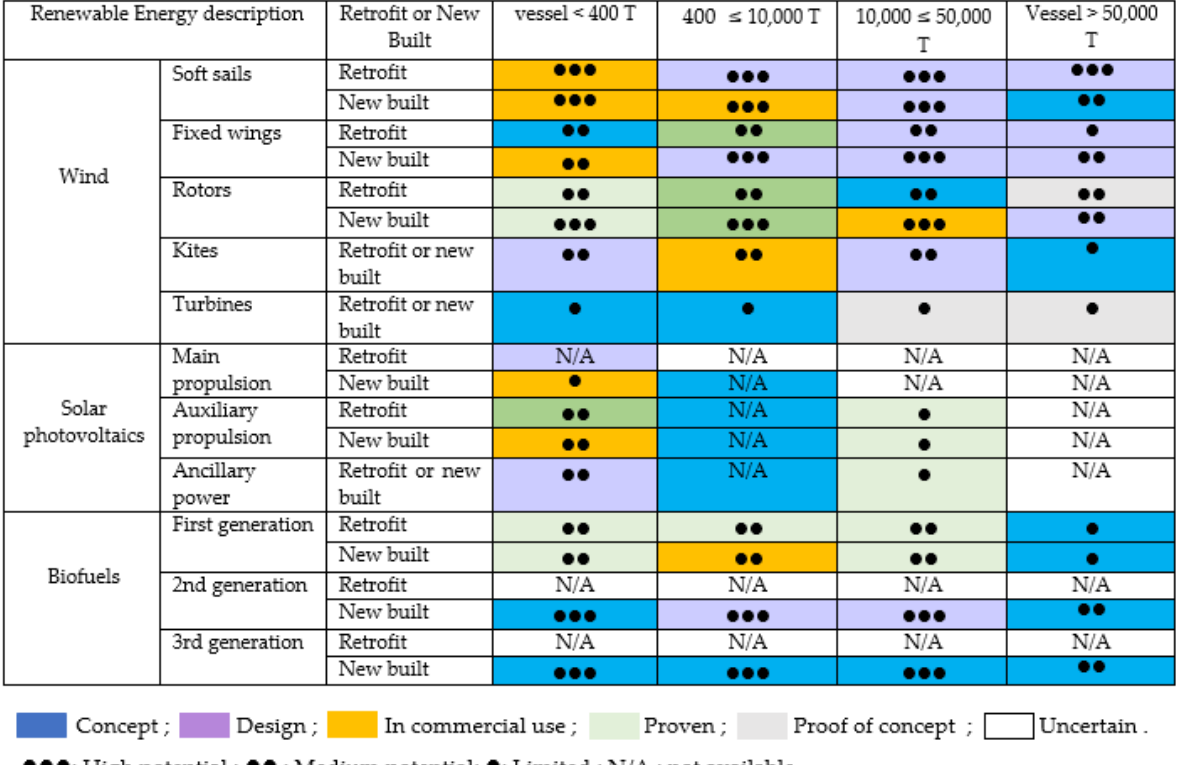
Figure 5. Innovative renewable energy technologies and their potential to be applied in the marine industry according to [32].